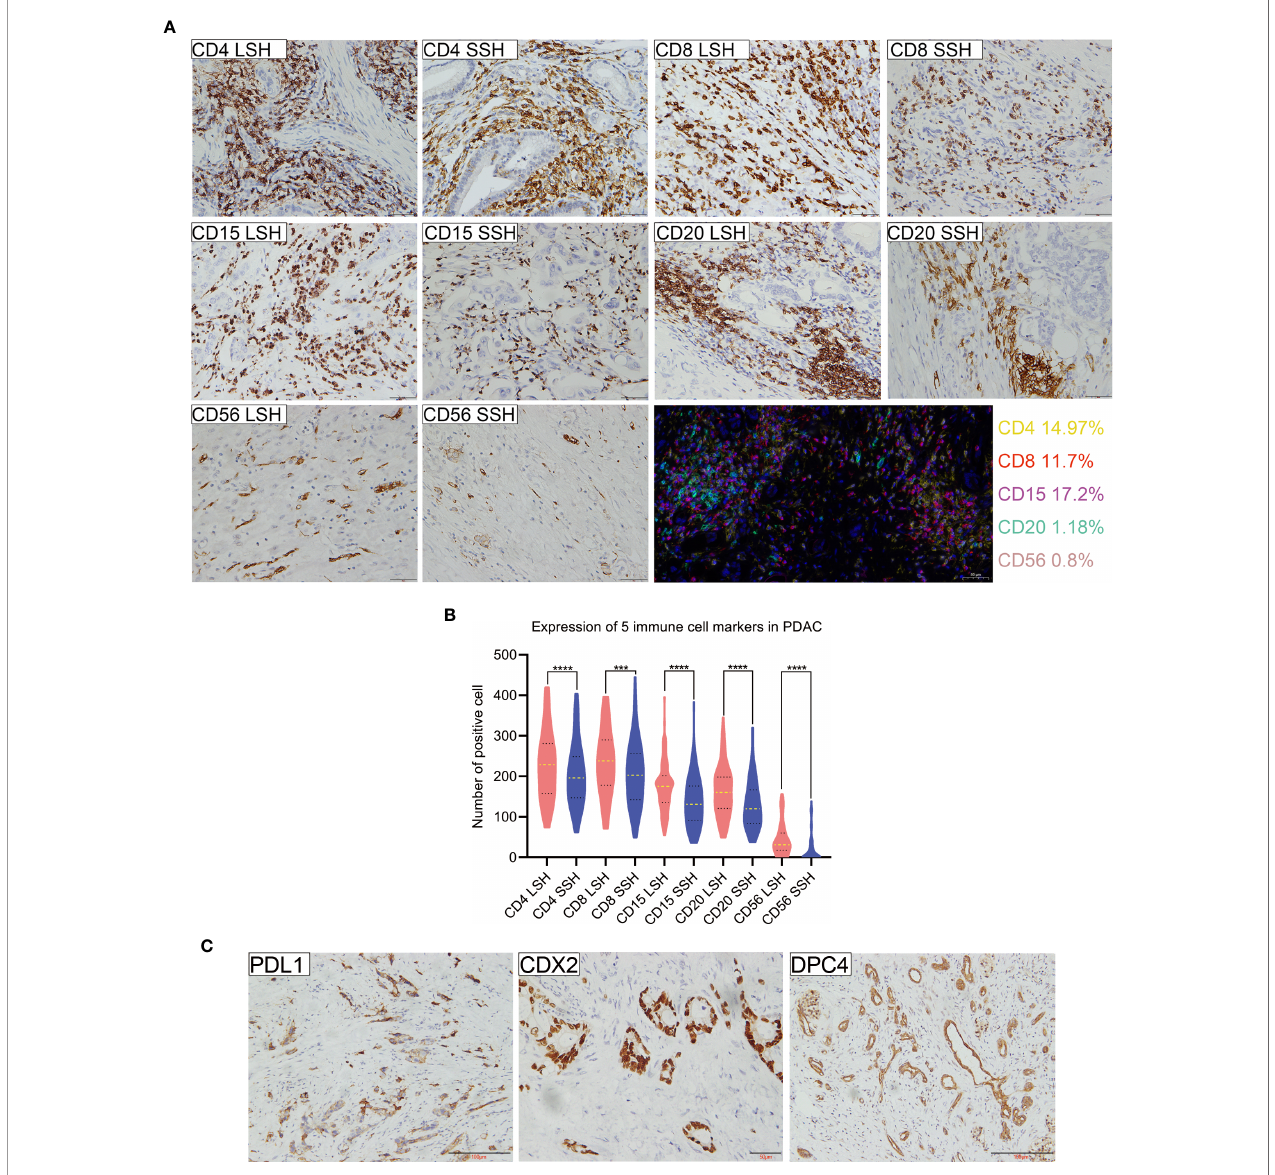
FIGURE 1 | Expression pro fi les of 5 immune cell markers and PDL1, CDX2, and DPC4 in PDAC specimens. (A) Patterns of positive expression of CD4, CD8, CD15, CD20, and CD56 in LSH and SSH (scale bar=50 m m) and colocalization of 5 types of immune cells present in the TME of pancreatic head ductal adenocarcinoma in a 50-year-old man based on multiple immunohistochemical staining. Basic information of patients corresponding to CD4, CD8, CD15, CD20, and CD56 levels (LSH vs SSH): a 72-year-old man, a 61-year-old man, and a 66-year-old woman with a tumor located in the head of pancreas and a 54-year-old woman and a 67-year-old man with a tumor located in the tail of pancreas, respectively. (B) The expression levels of fi ve immune cell markers were signi fi cantly higher in LSH than in SSH group (*** P =0.0002, **** P <0.0001). (C) PDL1, CDX2, and DPC4 expression in PDAC. Basic information of patients corresponding to CDX2, DPC4, and PDL1 levels: a 50-year-old man with a tumor located in the head of the pancreas and a 66-year-old man and a 60-year-old man with a tumor located in the tail of the pancreas, respectively. CD4LSH and CD4SSH represent the levels of CD4 expression in LSH and SSH, respectively, and other abbreviations can be deduced by analogy. PDAC, pancreatic ductal